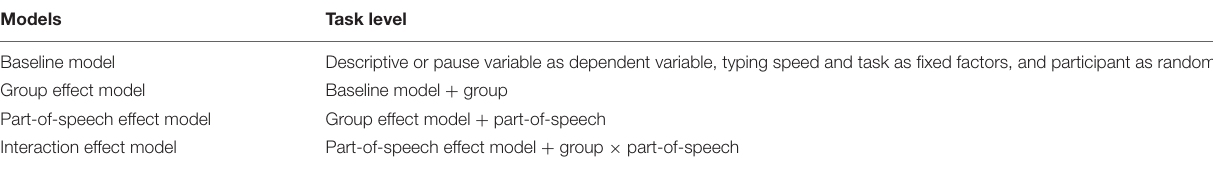
TABLE 1 | Overview of mixed-effects